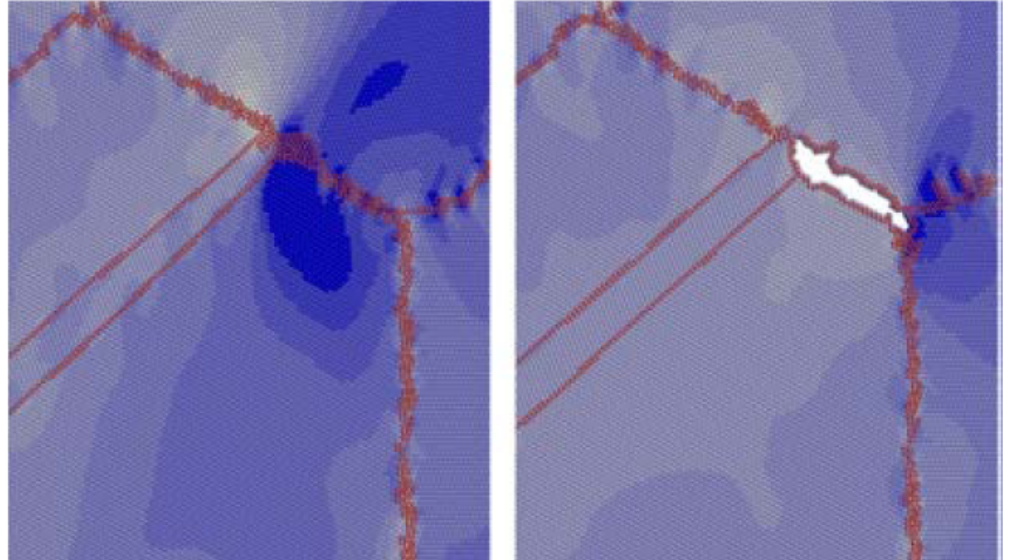
Figure 2. Twin–grain boundary (GB) interaction-induced regions of high stress (dark blue regions) leading to GB crack initiation in Mo according to molecular dynamics (MD) simulation by Zhang et al. [4] (with the permission of Elsevier, 2020). (Each pixelated dot represents an